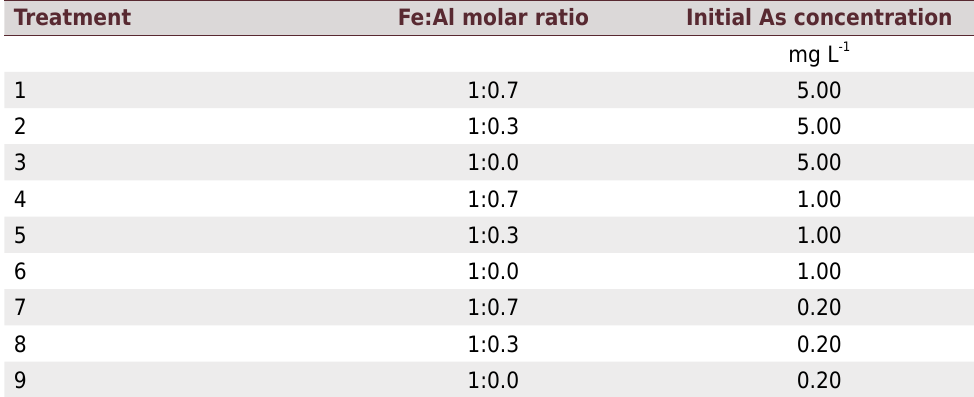
Table 1. Experimental conditions for sulfate and chloride experiments